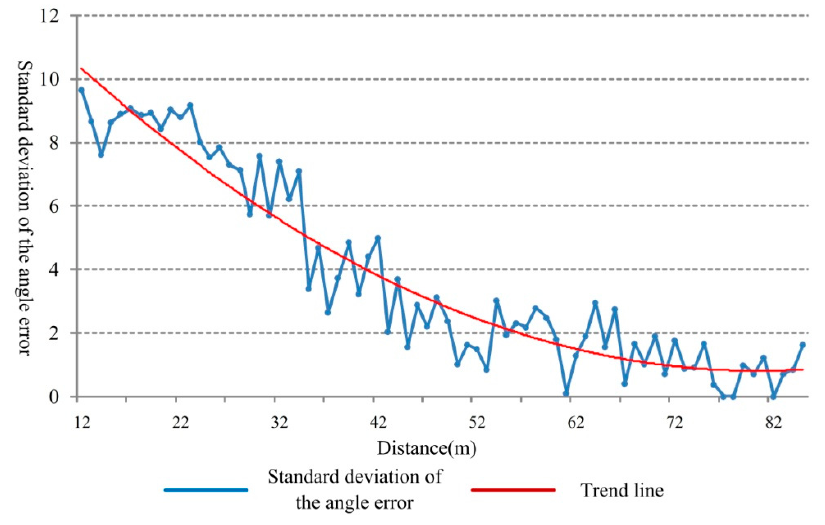
Figure 14. Standard deviation distribution of angle error under different distances.